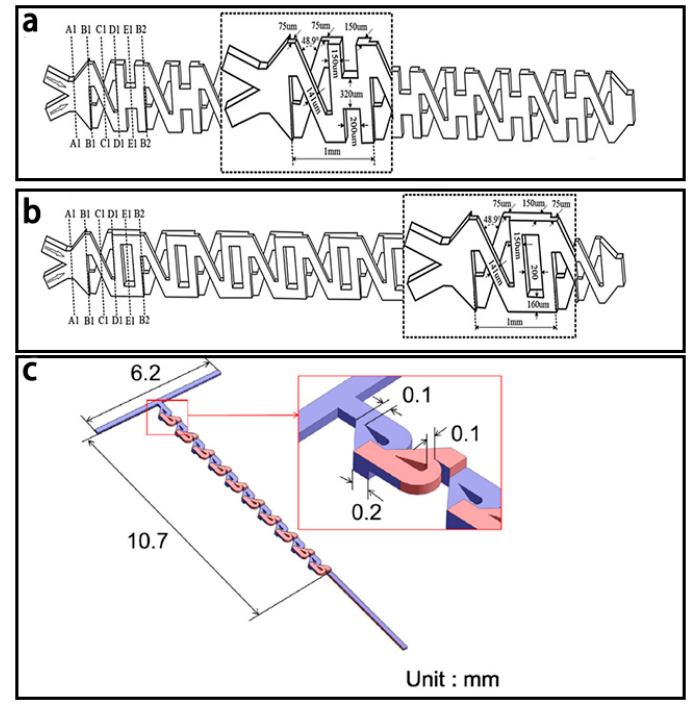
Figure 21. Schematic of the overbridge based micromixer ( a ) with XH-shaped structures; ( b ) with XO-shaped structures; and ( c ) with Tesla structures. Reproduced with permission from [116,117].